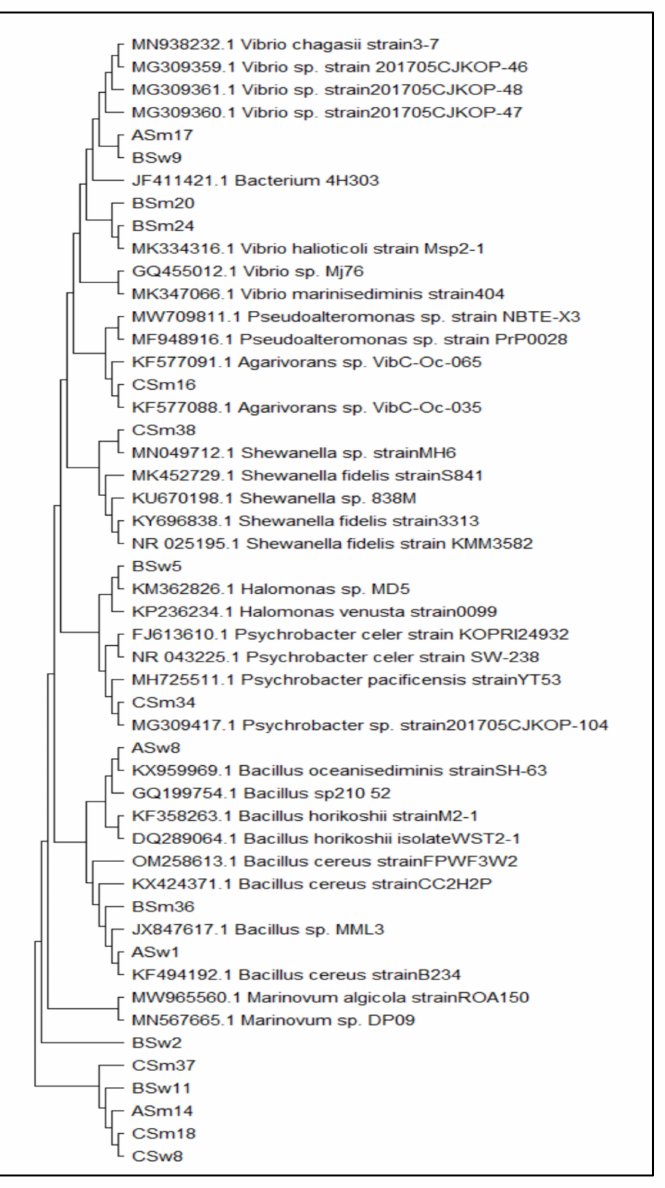
Figure 8. Phylogenetic tree for bacterial species associated with S. pistillata mucus and the surround- ing seawater. Phylogenetic analyses were conducted in MEGA11. There were a total of 1739 positions in the final dataset. A: Industrial Zone, B: Public Beach, C: Phosphate Berth, S: S. pistillata , m: mucus, w: